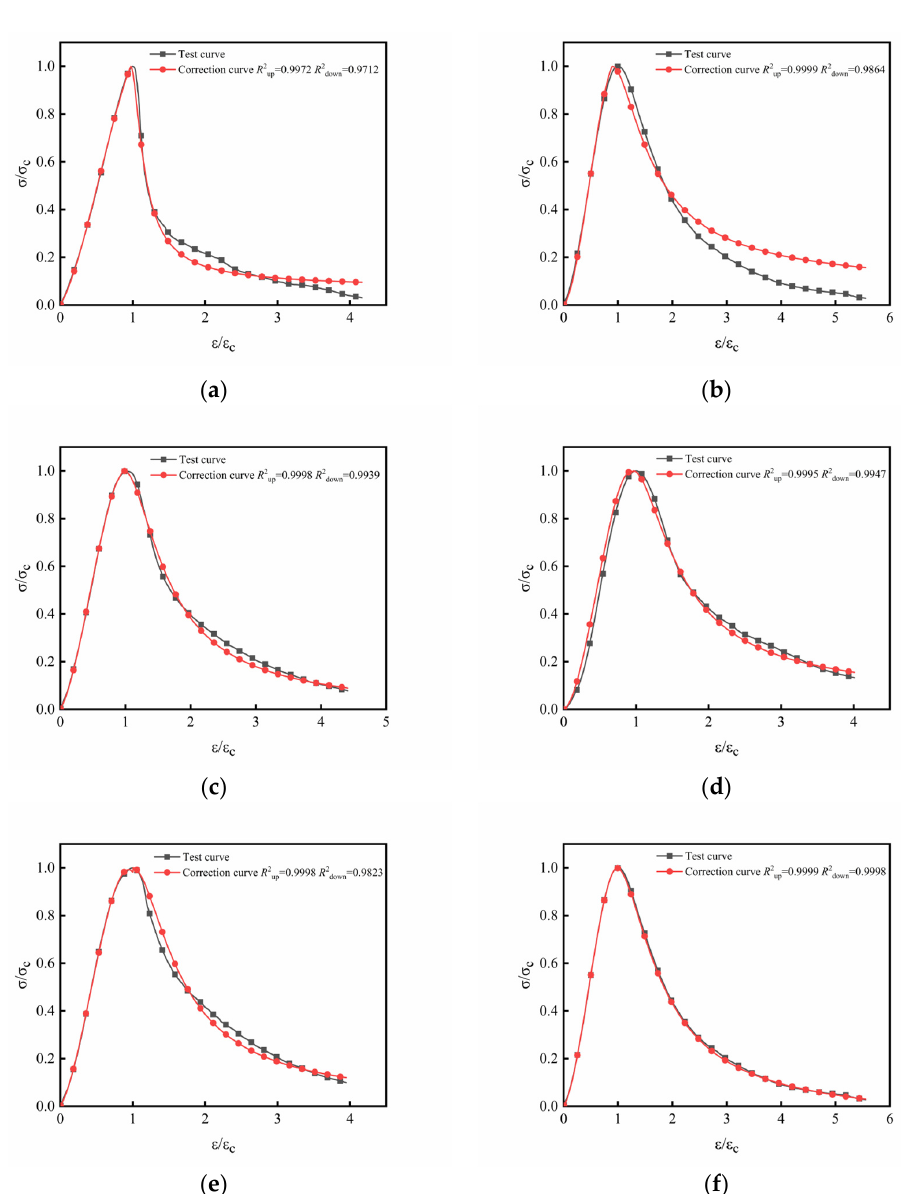
Figure 13. Comparison of modified constitutive model and experimental curve: ( a ) RC group; ( b ) BFC group; ( c ) PFC group; ( d ) BPRC 1 group; ( e ) BPRC 2 group; ( f ) BPRC 3 group.